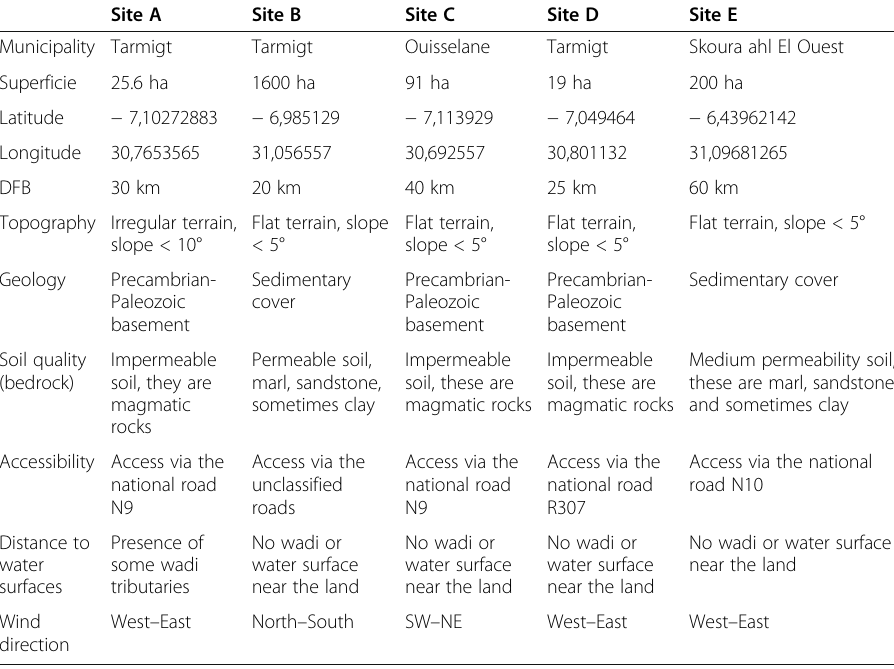
Table 7 The characteristics of the provisionally selected landfill